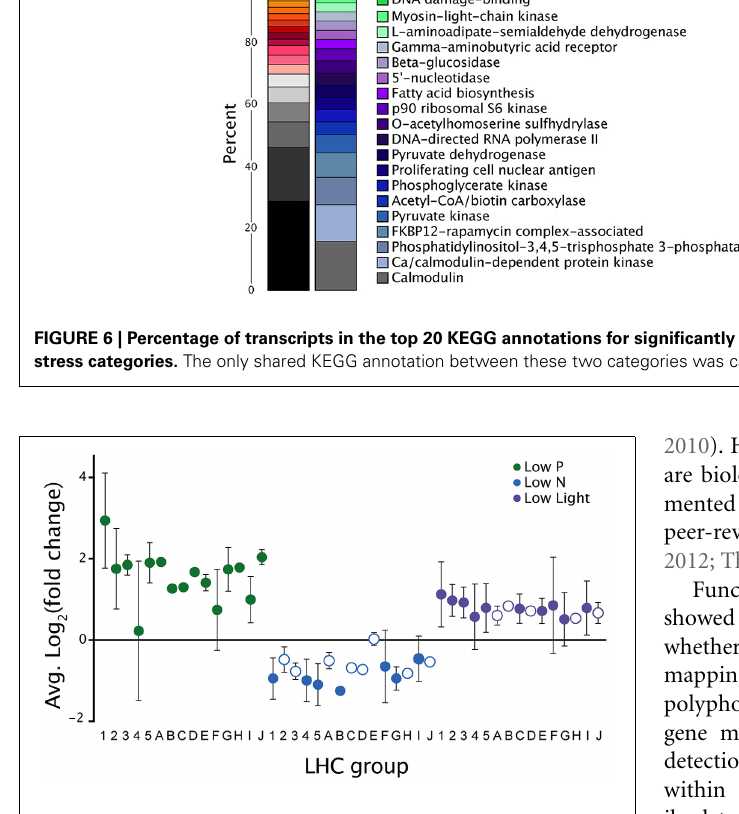
FIGURE 7 | Expression patterns of light harvesting complex (LHC) transcripts between treatments. The notation on the x-axis refers to the phylogenetic groups of different LHC genes identified in the A. anophagefferens CCMP 1984 genome (Gobler et al., 2011). Filled circles indicate LHC groups with significantly differentially expressed contigs in the LHC group. Open circles indicate a lack of significant differentially expressed contigs in the LHC group. Error bars denote standard